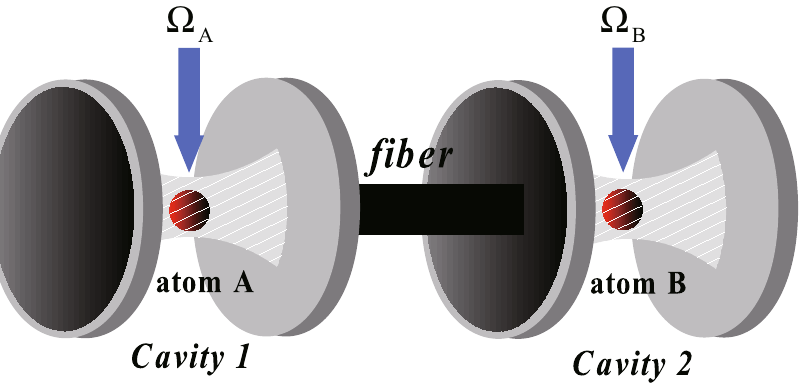
Figure 3. Schematic illustration for Fusing atomic W states in two separate